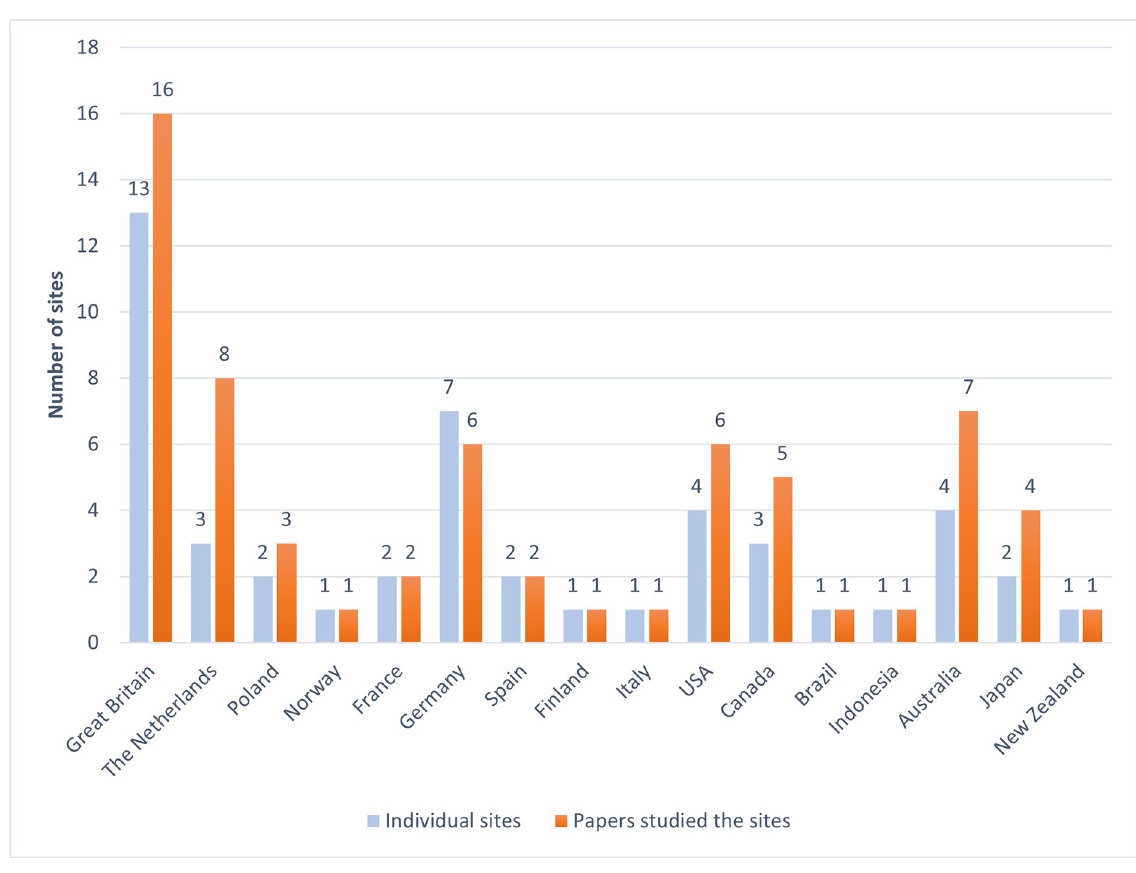
Fig 3. Number of CCUS sites per